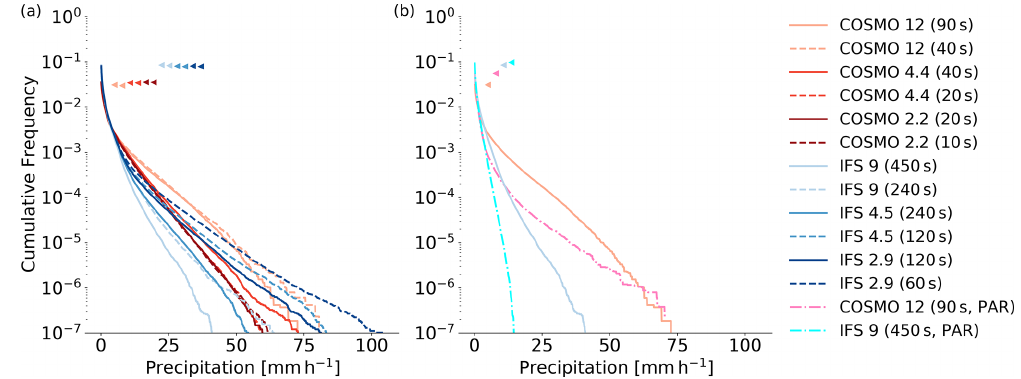
Figure 3. Cumulative frequency of accumulated hourly precipitation over the European domain for the whole 48h period. Panel (a) shows all runs with explicit deep convection and two different time steps per spatial resolution. Panel (b) shows the coarser runs with parameterized (PAR) and with explicit deep convection. The triangles indicate the frequency of precipitation ≥ 0 . 1mmh − 1 of the respective simulations.